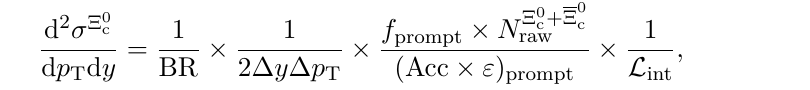
Figure 3 . Correlation matrix between the generated Ξ 0 pair p T , obtained from the simulation based on PYTHIA 8 described in the